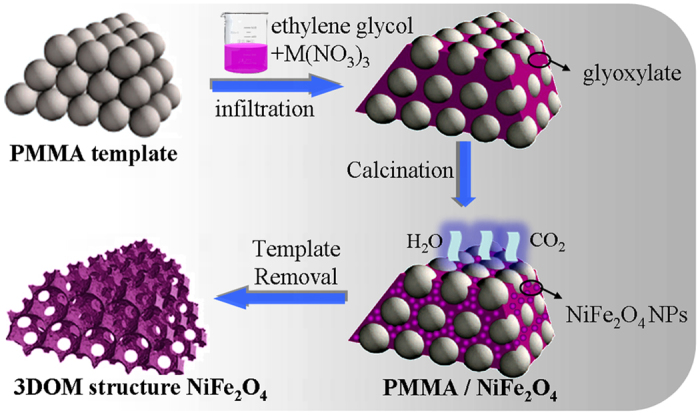
Formation mechanism of the 3D network structure NiFe2O4 samples.